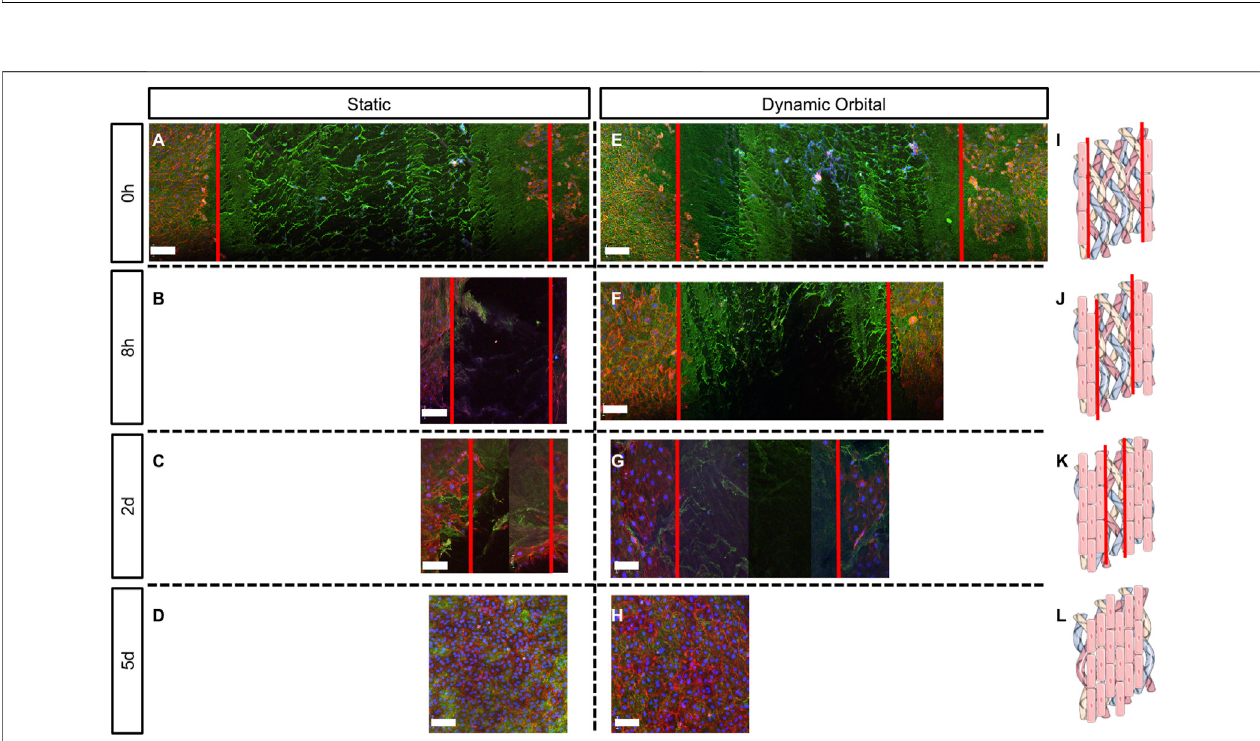
FIGURE 4 | Scratch assay performed on hTEMs seeded with ECFCs and cultured with FBS as medium supplement. Scratch was performed in the middle of the hTEM (red lines). ECFCs were cultured for up to 5 days under static (A – D) or dynamic orbital conditions (E – H) , and fi nally stained for Collagen III (green), phalloidin (red) and DAPI (blue) at four different time points (0 h, 8 h, 2 days, and 5 days). (A,E) : Control scratch performed at time 0, under static and dynamic orbital conditions, respectively. (B,F) : ECFCs migration at 8 h timepoint under static and dynamic orbital conditions, respectively. (C,G) : ECFCs migration at 2 days timepoint under staticanddynamicorbitalconditions,respectively. (D,H) :ECFCsreachedcon fl uencyafter5 daysfromscratch. (I – L) :Schematicrepresentationofthescratchassaytest on hTEMs (Images adapted from Servier Medical Art under a creative common attribution 3.0 unported license) (500 µm scale bars).